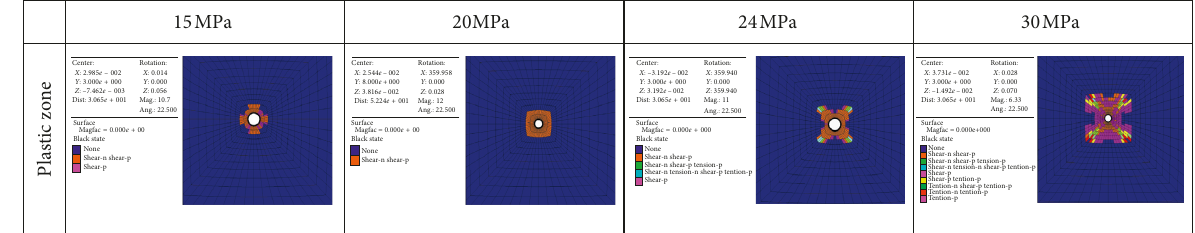
Figure 6: Plastic zone distribution under the load of 15 ∼ 30 MPa.